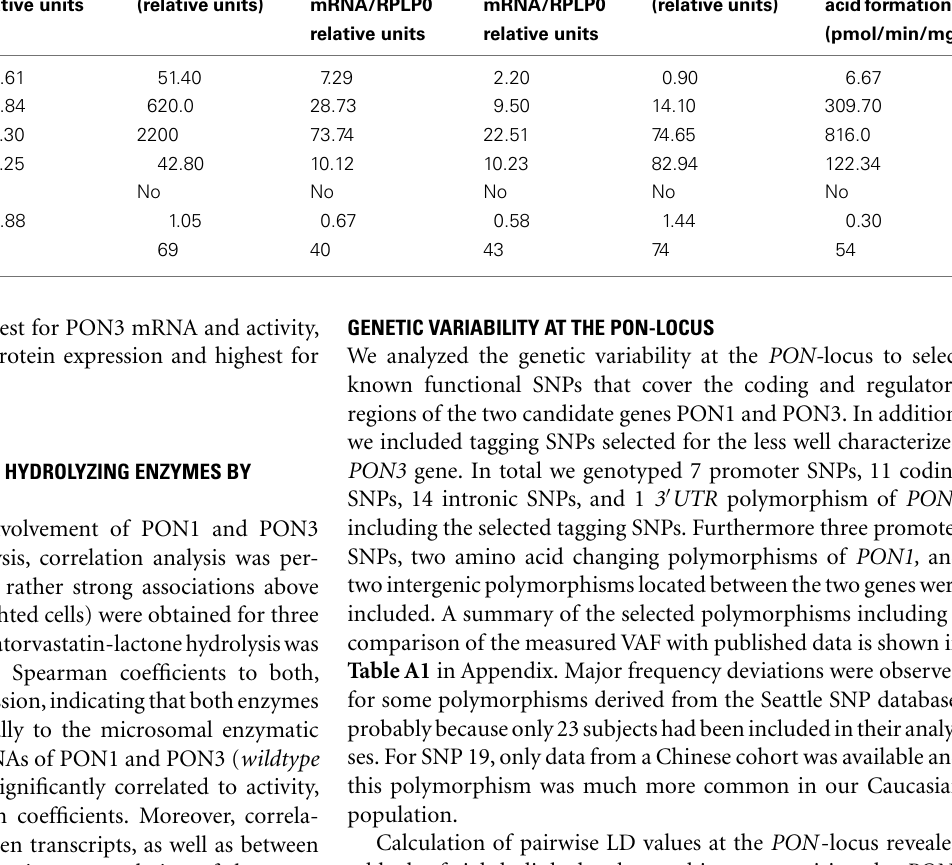
fractions of livers 1–5, on a human liver microsome pool (lane 11) and on lysate of primary human hepatocytes. (C) Deglycosylation was performed by analysis with ( + ) or without ( − ) pretreatment by endoglycosidase PNGase F.